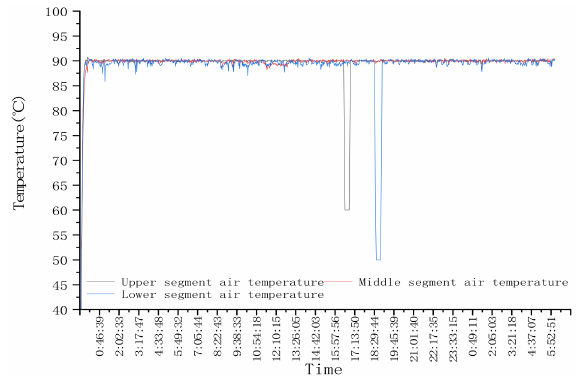
Figure 10. Pulse change diagram of hot air temperature.